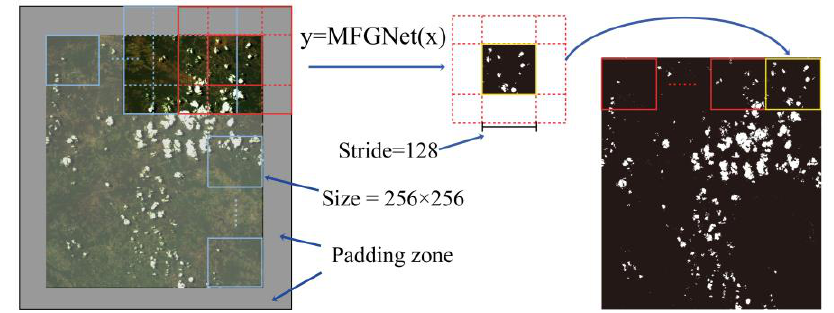
Figure 9. Overlap-tile strategy for seamless segmentation of GF-5 images.